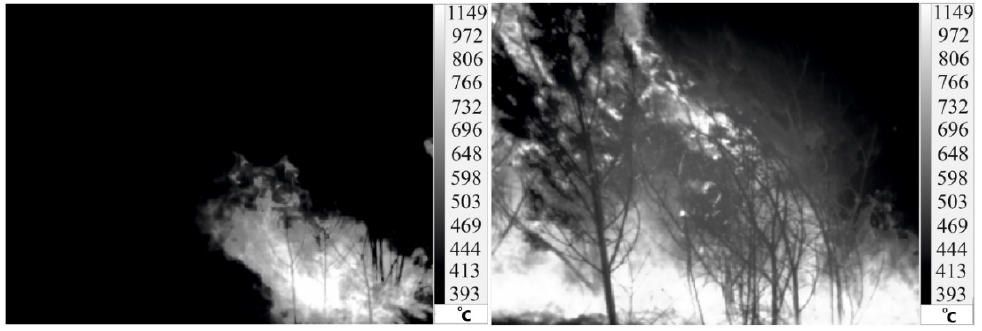
Figure 4. Flame thermogram of a model wildfire front.